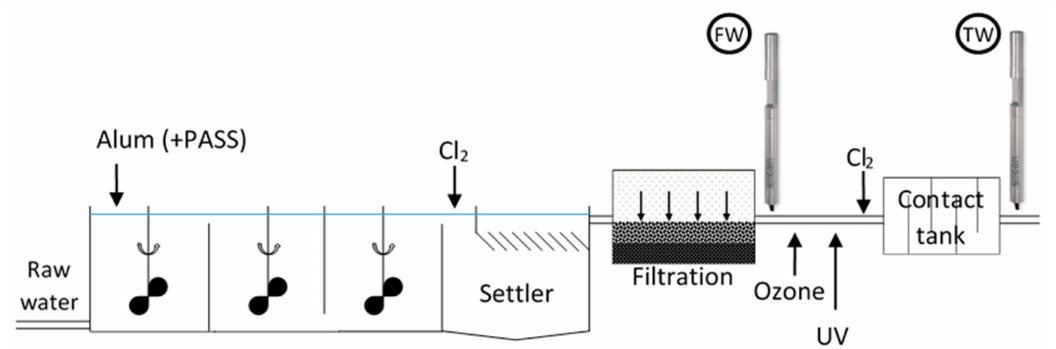
Figure 2. Overall pattern of the water treatment plant under